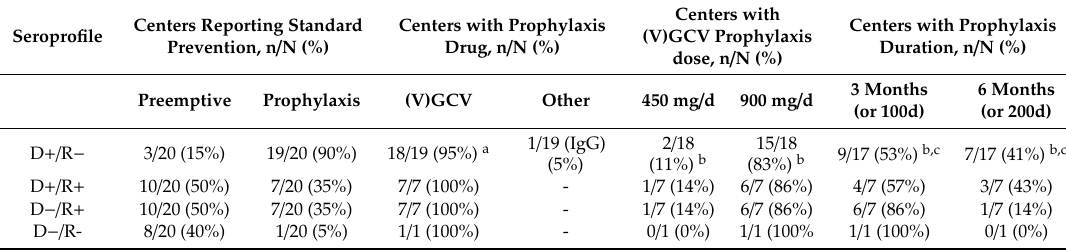
Table 1. Summary of prevention strategies as reported by German liver transplant centers. Centers with Centers with Prophylaxis Centers Reporting Standard Centers with Prophylaxis Seroprofile (V)GCV Prophylaxis Duration, n / N (%) Prevention, n / N (%) Drug, n / N (%) dose, n / N (%) Preemptive Prophylaxis (V)GCV Other